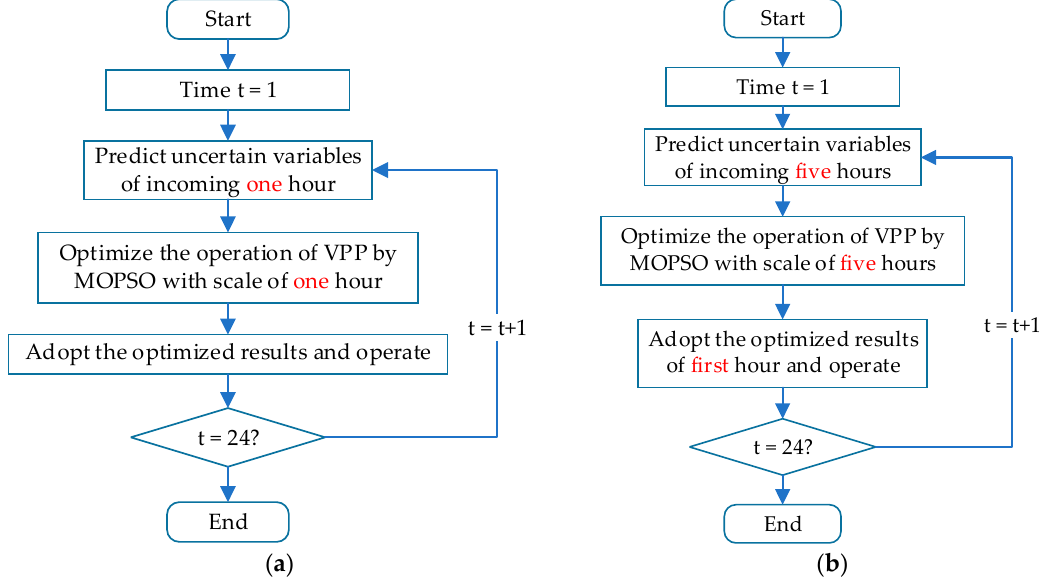
Figure 14. Schemes of two strategies: ( a ) improvisational; ( b ) foresighted.